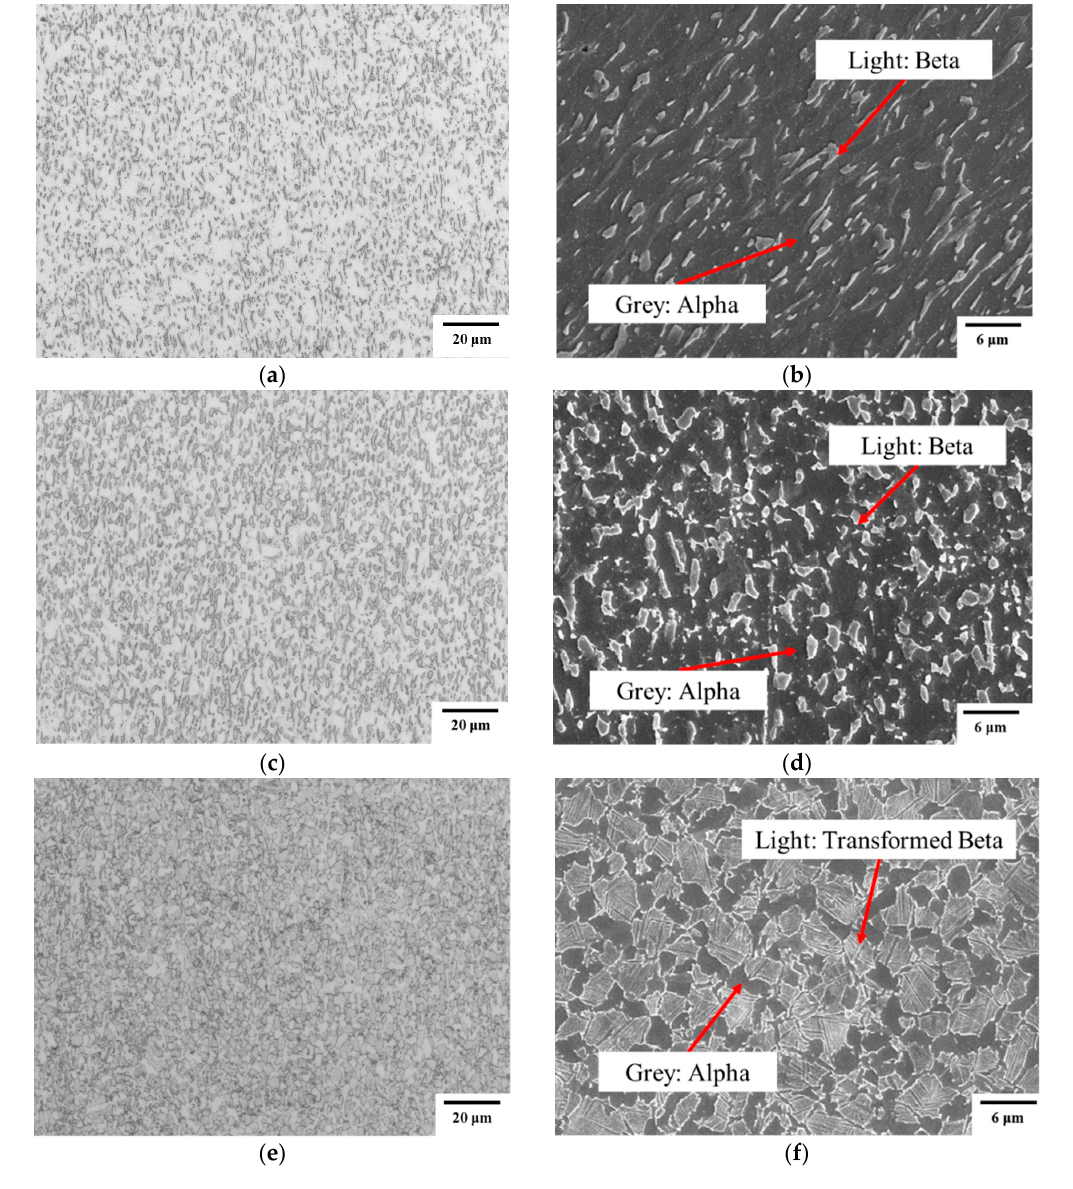
Figure 7. The microstructure of TA15 conditioned at constant strain rate 1 s − 1 : ( a , b ) 700 °C; ( c , d ) 800 °C and ( e , f ) 900 °C, after hot deformation.